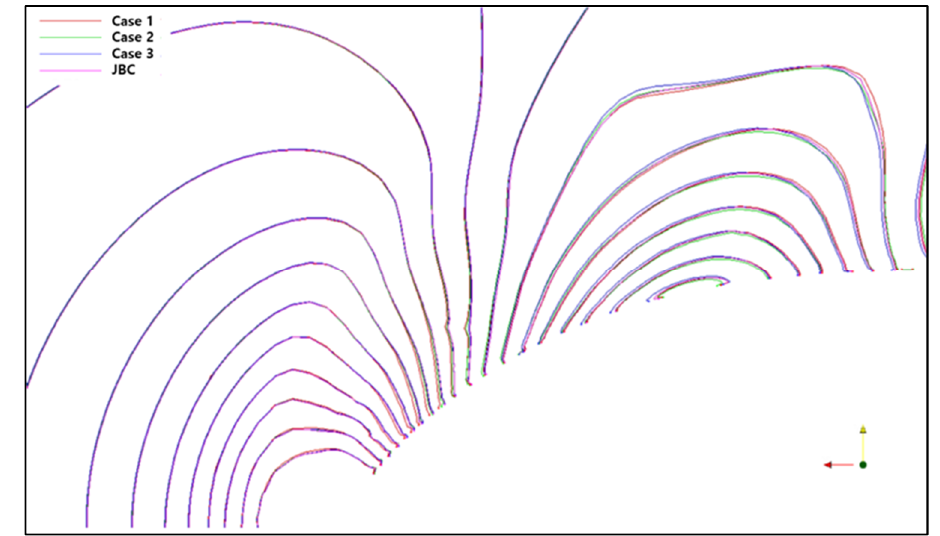
Figure 13. Comparison of wave height contour around the bow.